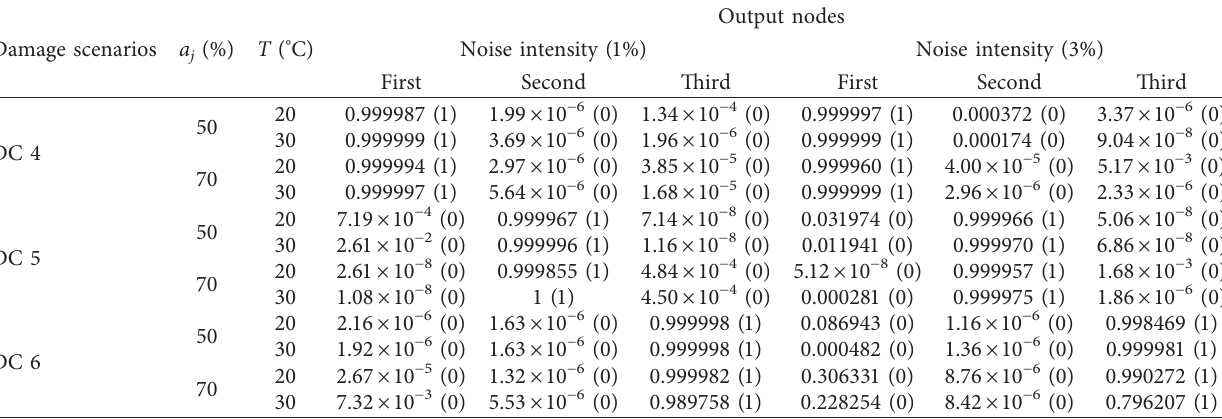
Table 10: The identification results of damage locations when two braces are damaged with noises. Damage scenarios a j (%) T ( ° C)